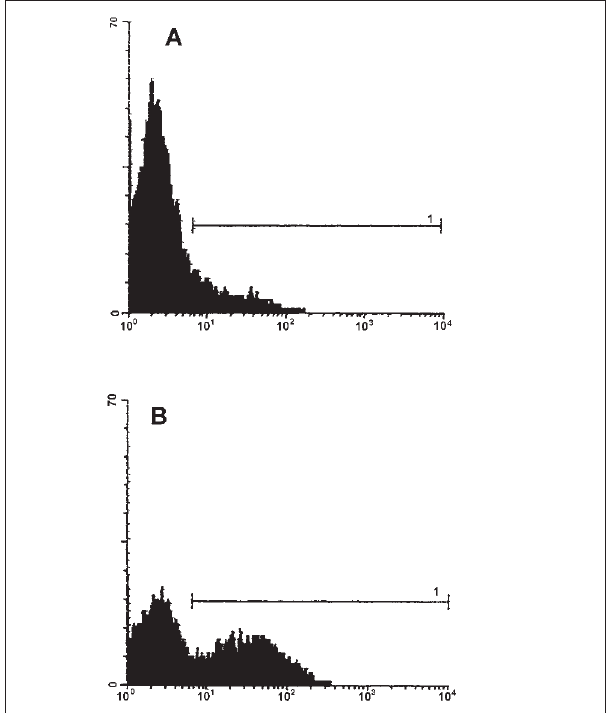
Figure 3) Florescence-activated cell sorter analysis of rat platelet reac- tivity with antirat CD62p. Top Control rat platelets. Bottom Endocar- ditis rat platelets, stained with antirat CD62p followed by